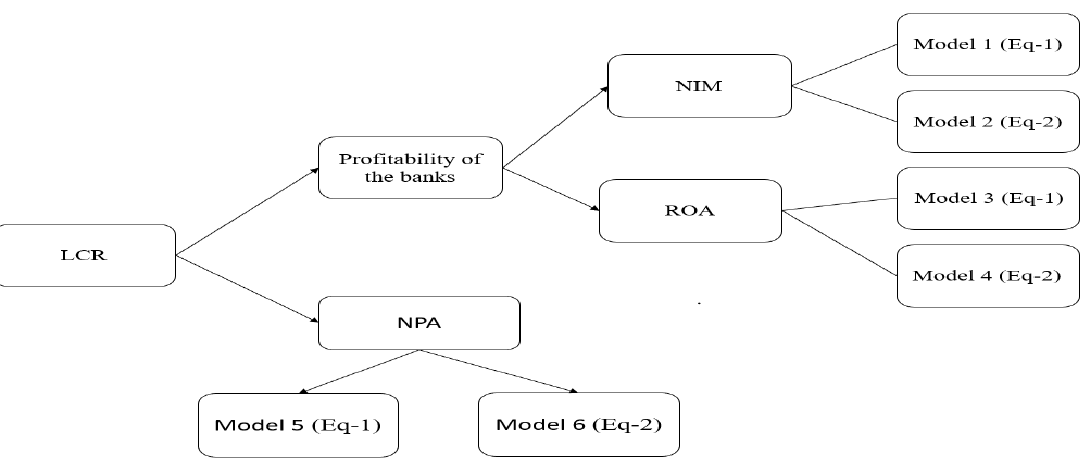
Figure 1. Conceptual Model of the study. Source: Author compilation. Note: Figure 1 explains the theoretical model adopted for the study.